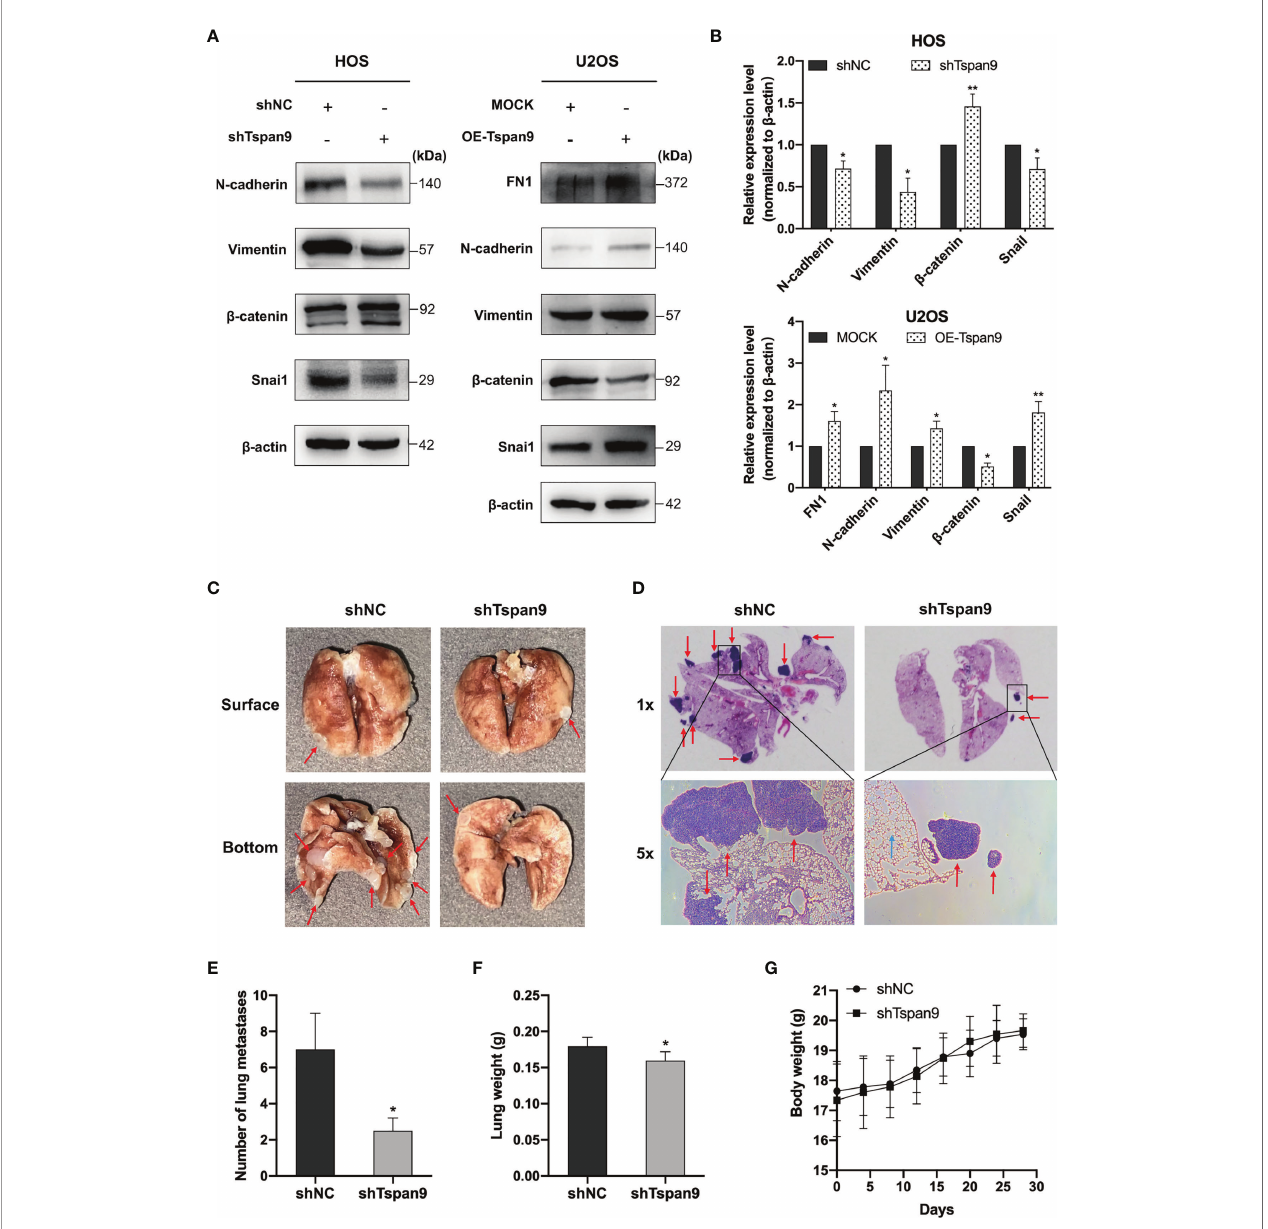
FIGURE 5 | Tspan9 regulates EMT, and knocking down of it impairs in vivo OS cell metastasis. (A) EMT marker protein levels and associated transcription factor expression were assessed in HOS and U2OS cells stably expressing shTspan9/OE-Tspan9 or control constructs. (B) Quanti fi cation of the Western blotting results presented in (A) . (C, D) HOS cells stably expressing shTspan9 or control constructs were injected via the lateral tail vein into nude mice to establish a model of pulmonary metastasis (n=5/group). Left: representative lung images; Right: representative H&E staining results (1x and 5x). Pulmonary nodules are indicated by red arrows, while normal alveolar tissue is indicated by blue arrows. (E) Numbers of metastatic pulmonary nodules in the indicated groups. (F) Lung weights on day 28 post-HOS tumor cell injection. (G) Murine body weight was assessed every 4 days. * P < 0.05; ** P <